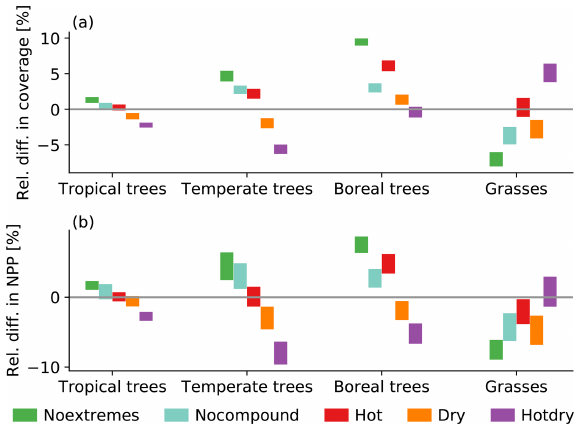
Figure 2. Relative difference in the scenarios from the Control scenario for (a) coverage and (b) annual NPP. The bars show the minimum-to-maximum range over the 100-year-long